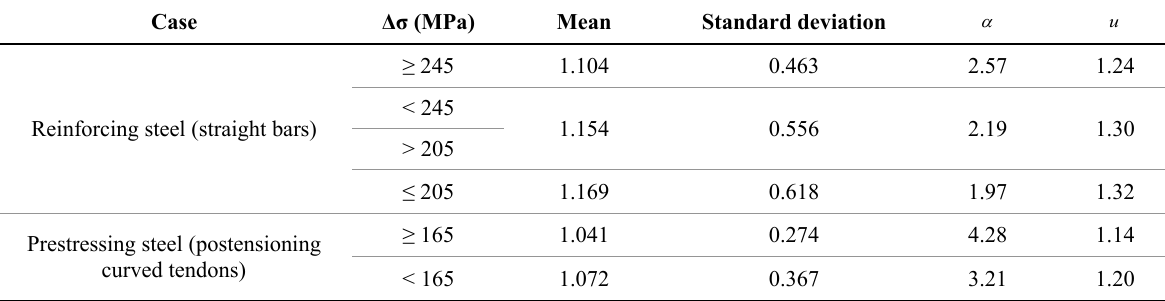
Table 3. Parameters of variable i DM (adapted from Crespo-Minguillón and Casas [6]). Case Δσ (MPa) Mean Standard deviation α u ≥ Reinforcing steel (straight bars)